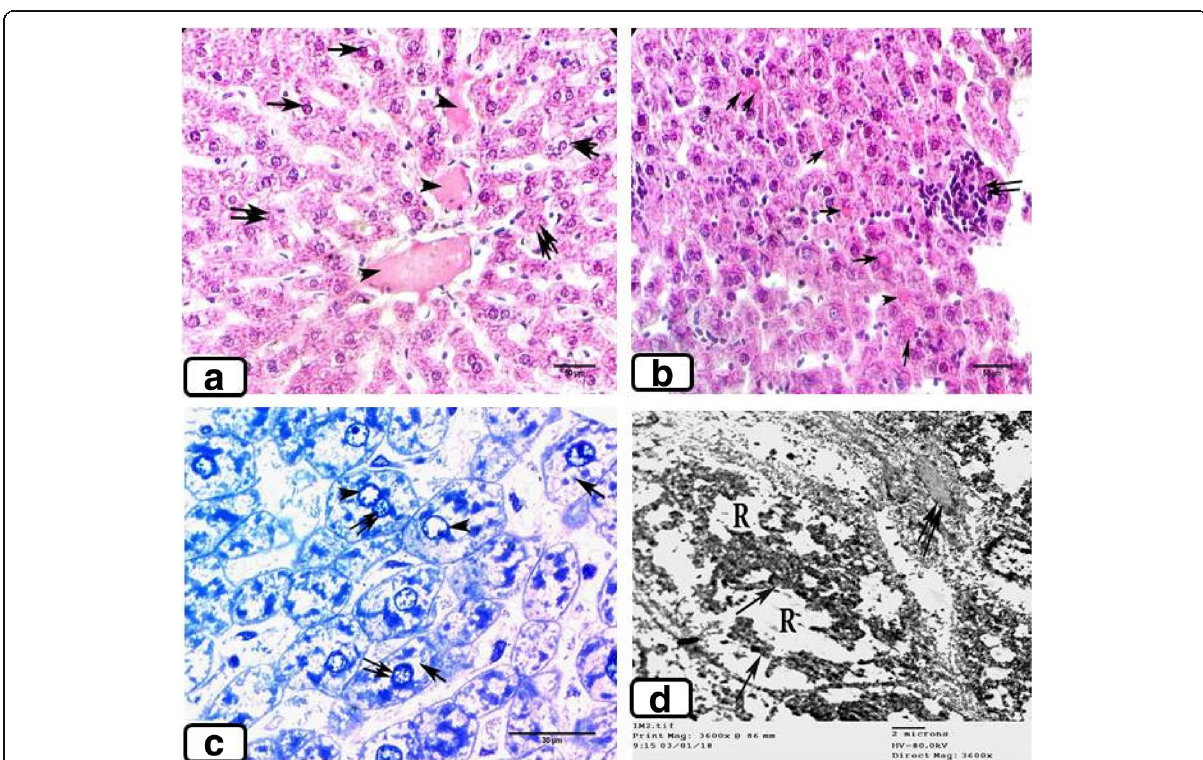
Fig. 3 M2 group liver showing a vacuolated cytoplasm with deeply stained nuclei ( ↑ ), degeneration of some hepatocytes ( ↑↑ ), and congestion of blood vessels and central vein (arrowhead) (H&E). Note: the Kupffer cell puched into the sinusoids lumen. b Eosinophilic stain (red color) of nuclei ( ↑ ), leucocytic aggregation between hepatocytes ( ↑↑ ), degeneration of many hepatocytes (arrowhead), and other hepatocytes with vacuolated cytoplasm and pyknotic nuclei (H&E). c Vacuolated cytoplasm of many hepatocytes ( ↑ ) with deeply stained nuclei ( ↑↑ ) and the nucleoplasm of some nuclei devoid chromatin (arrowhead) (toluidine blue). d Ultrastructure of hepatocytes showing many rarified areas in the cytoplasm (R) and disorganization and dissociation of cellular organelles (necrosis) ( ↑ ). Note: collagenous fibers between hepatocytes ( ↑↑